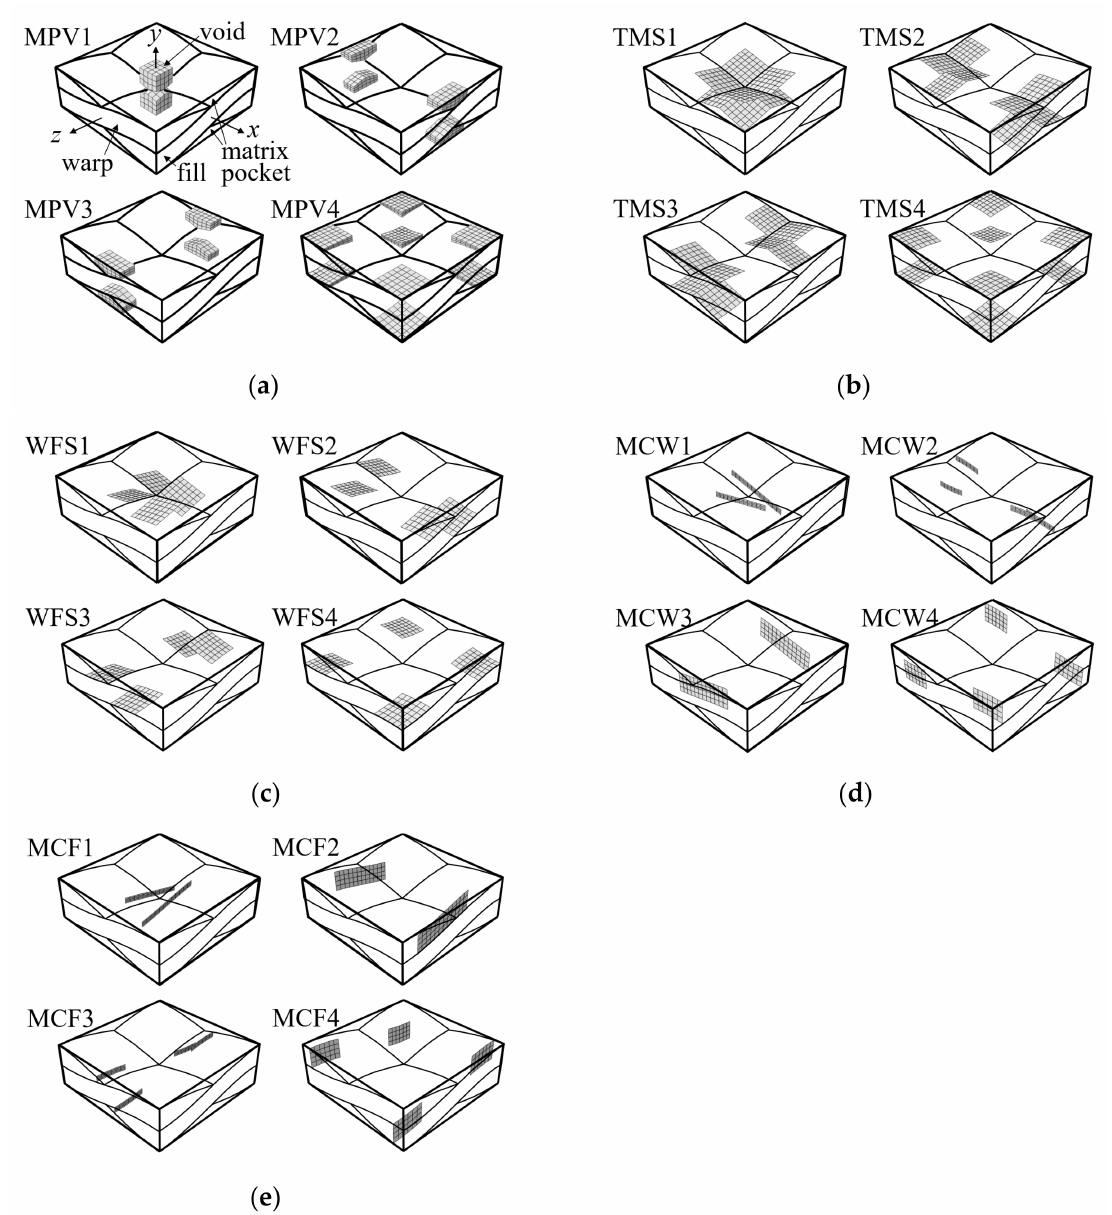
Figure 16. Definition of defect codes by types and location: ( a ) matrix pocket void; ( b ) tow and matrix pocket separation; ( c ) warp tow and fill tow separation; ( d ) matrix direction crack in warp tow; and ( e ) matrix direction crack in fill